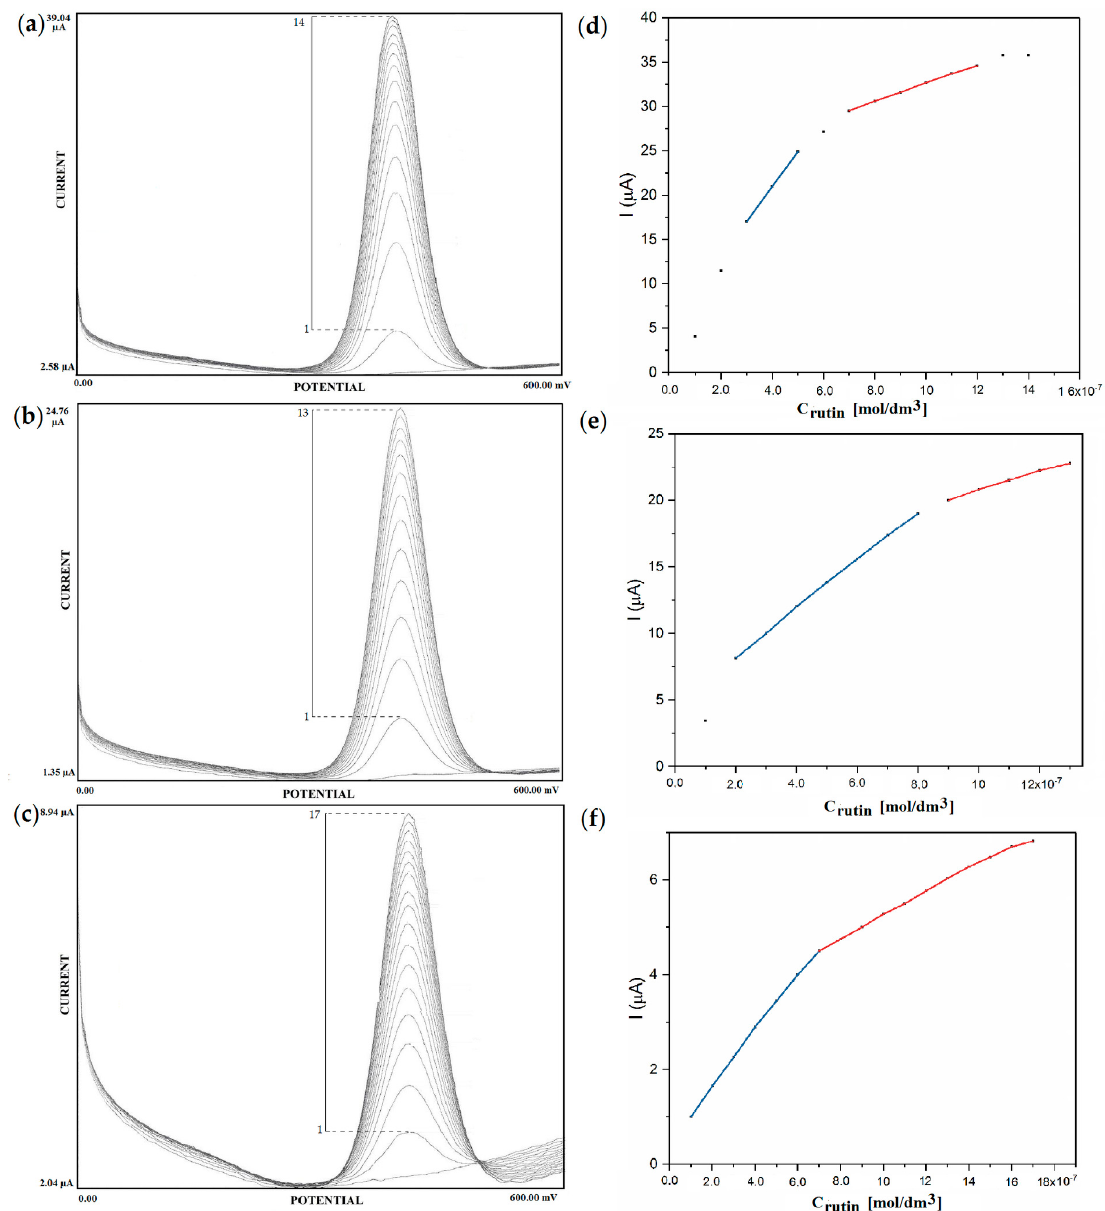
Figure 2. Square-wave voltammograms for Rutin solutions at the following concentrations: (1) 0.1, (2) 0.2, (3) 0.3, (4) 0.4, (5) 0.5, (6) 0.6, (7) 0.7, (8) 0.8, (9) 0.9, (10) 1.0, (11) 1.2, (12) 1.3, (13) 1.4, (14) 1.5, (15) 1.6, (16) 1.7, (17) 1.8 ( µ mol/dm 3 ) ( a ) of GCE/laccase 10 , ( b ) GCE/laccase 15 , ( c ) GCE/laccase 30 and calibration curves of ( d ) GCE/laccase 10 , ( e ) GCE/laccase 15 , ( f ) GCE/laccase 30.